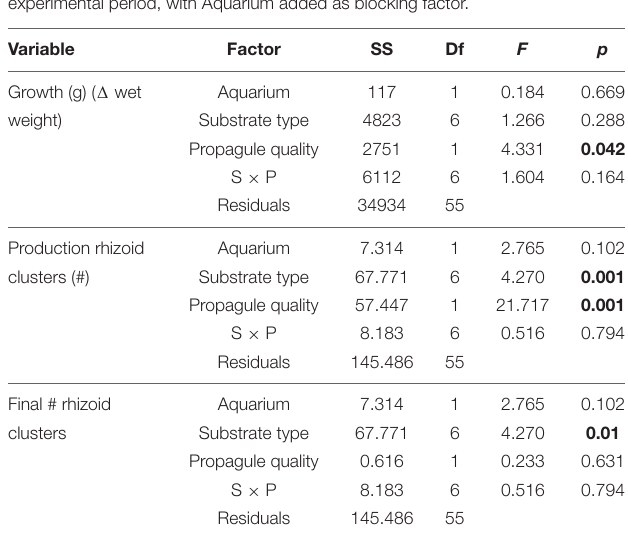
TABLE 4 | ANOVA (type II) test results on growth performance (change in total wet weight, production of rhizoid clusters, and final rhizoid number) for factors Substrate type and Propagule quality and their interaction over the 10 days experimental period, with Aquarium added as blocking factor.